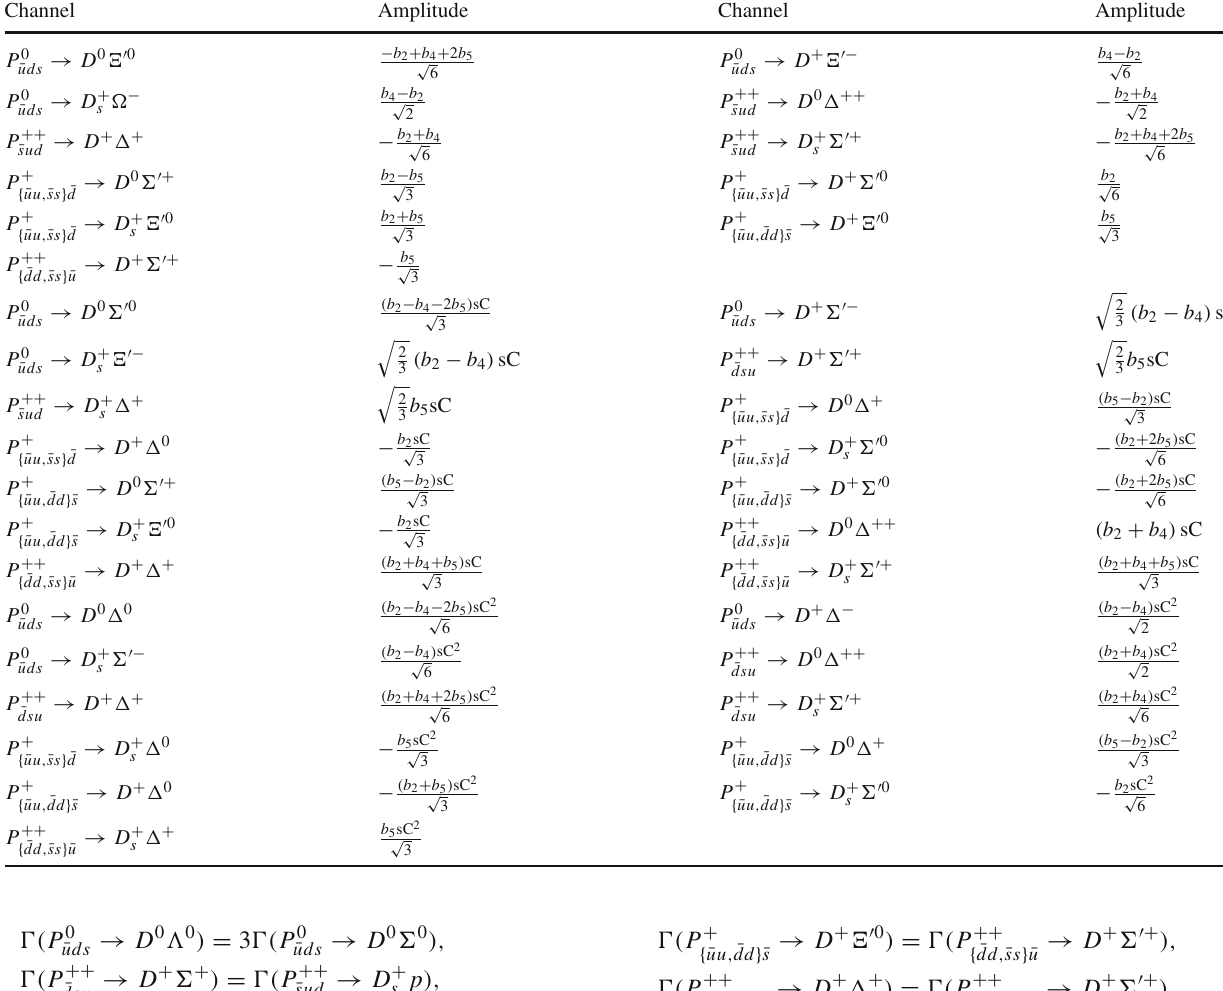
Table 5 Pentaquark P 6 ( cc ¯ qqq ) decays into charmed mesons and decuplet light baryons with Cabibbo allowed, the singly Cabibbo suppressed and doubly Cabibbo suppressed Channel Amplitude Channel Amplitude → D 0 (cid:6) (cid:3) 0 − b 2 + b 4 + 2 b 5 √ P 0 ¯ uds